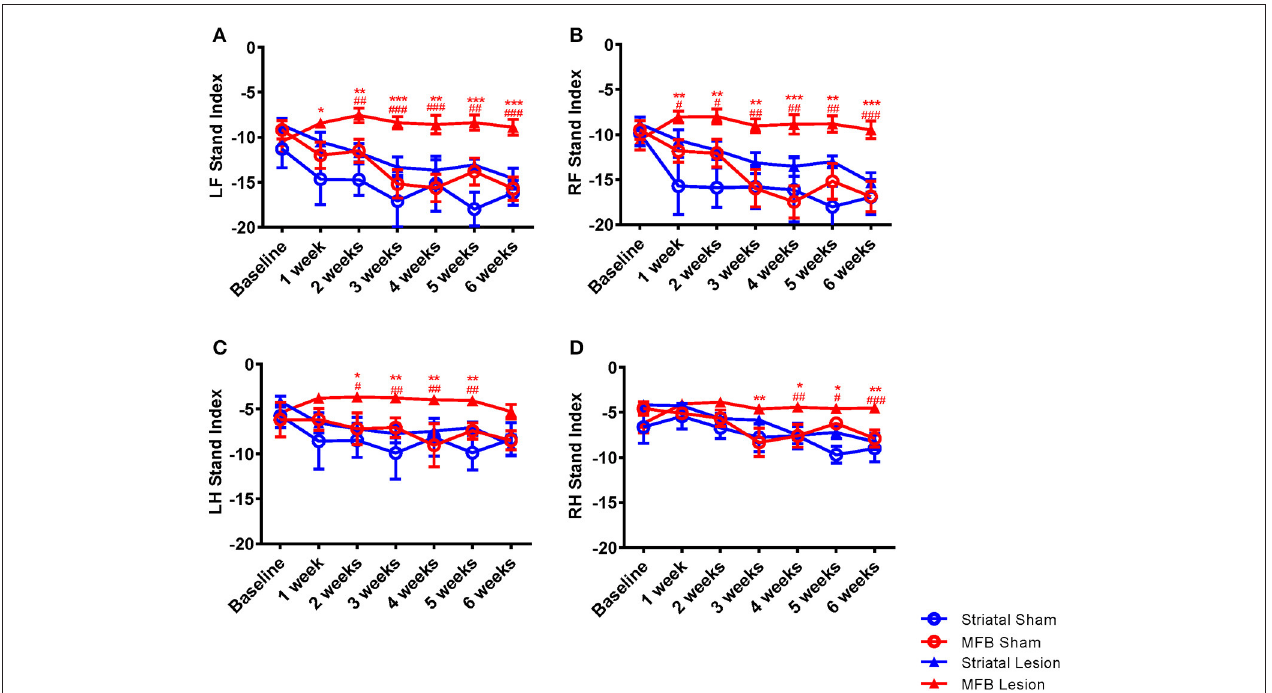
FIGURE 5 | Graphs demonstrating the stand index following MFB or striatal 6-OHDA lesioning. (A) LF: left front, (B) RF: right front, (C) LH: left hind, and (D) RH: right hind. Data shown as mean ± s.e.m. *Indicates a significant difference on the lesion group when compared to its control (blue for striatal cohort and red for MBF cohort) and # indicates differences of MFB lesion vs. striatal lesion animals * P ≤ 0.05; ** P < 0.01; *** P < 0.001 (Two-way repeated measures ANOVA with Tukey’s or Dunnett’s post-hoc multiple